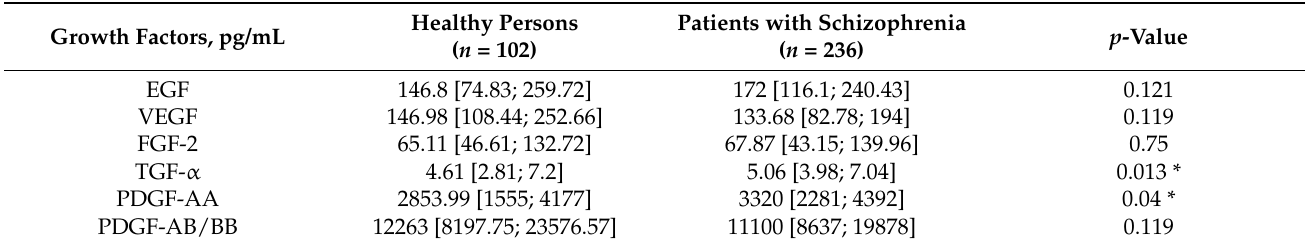
Table 2. Concentration of serum growth factors in serum of patients with schizophrenia and healthy persons (Me [Q1; Q3]).